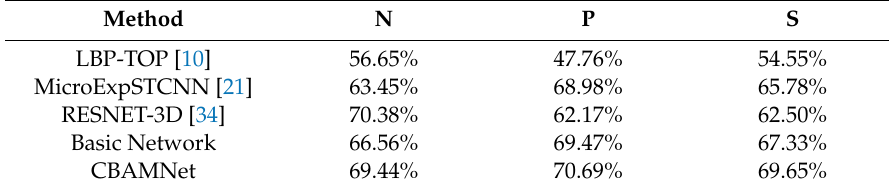
Table 7. Comparison of di ff erent methods on CASME